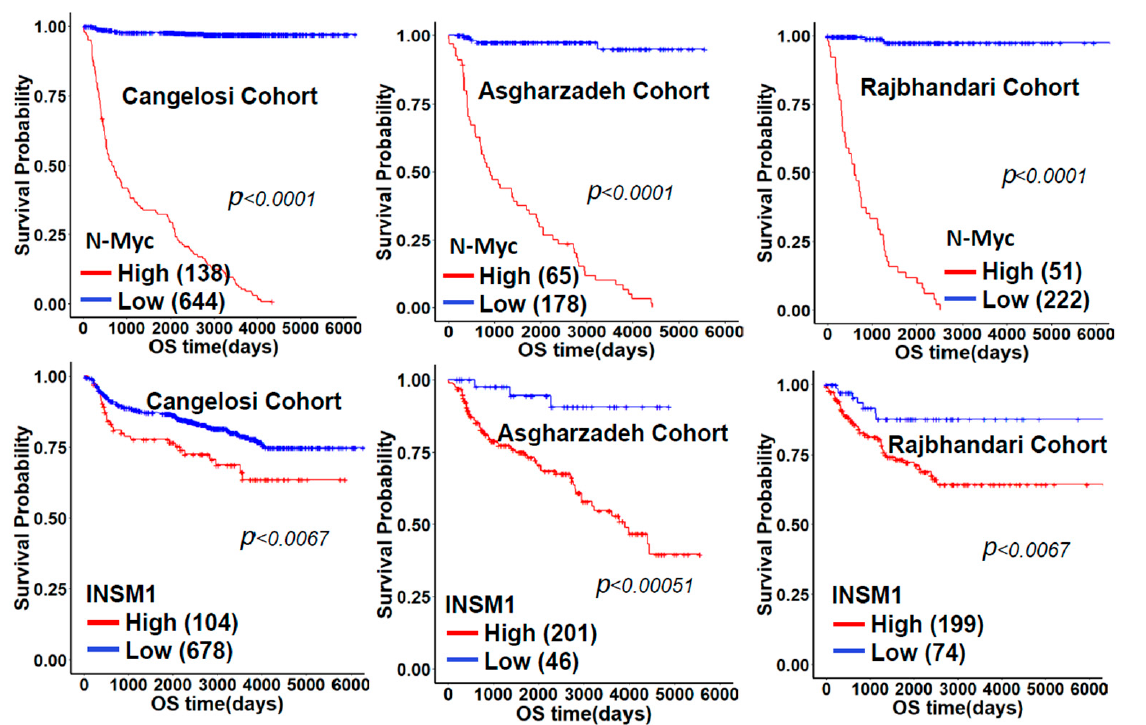
Figure 4. N-Mvc and INSM1 expression consistently associated with NB overall survival (OS). A Kaplan-Meier plot shows the OS time and survival probability in NB patients. NB patients derived from Cangelosi, Asgharzadeh, and Rajbhandari cohorts were divided into high-or low-N-Myc or INSM1 expression based on the cut-point using maximally selected rank statistics (maxstat).